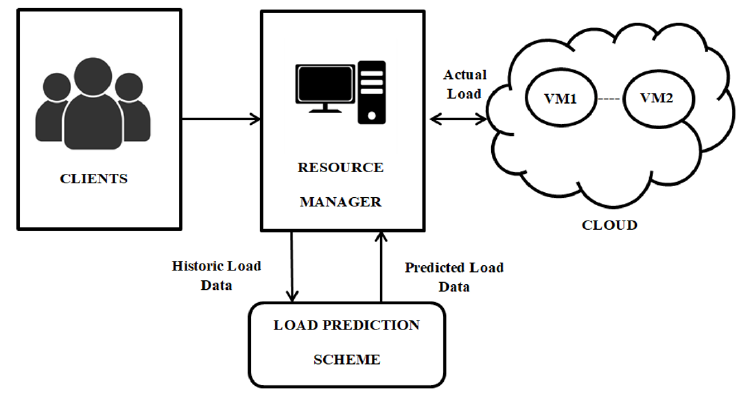
Figure 2. Load Prediction Process